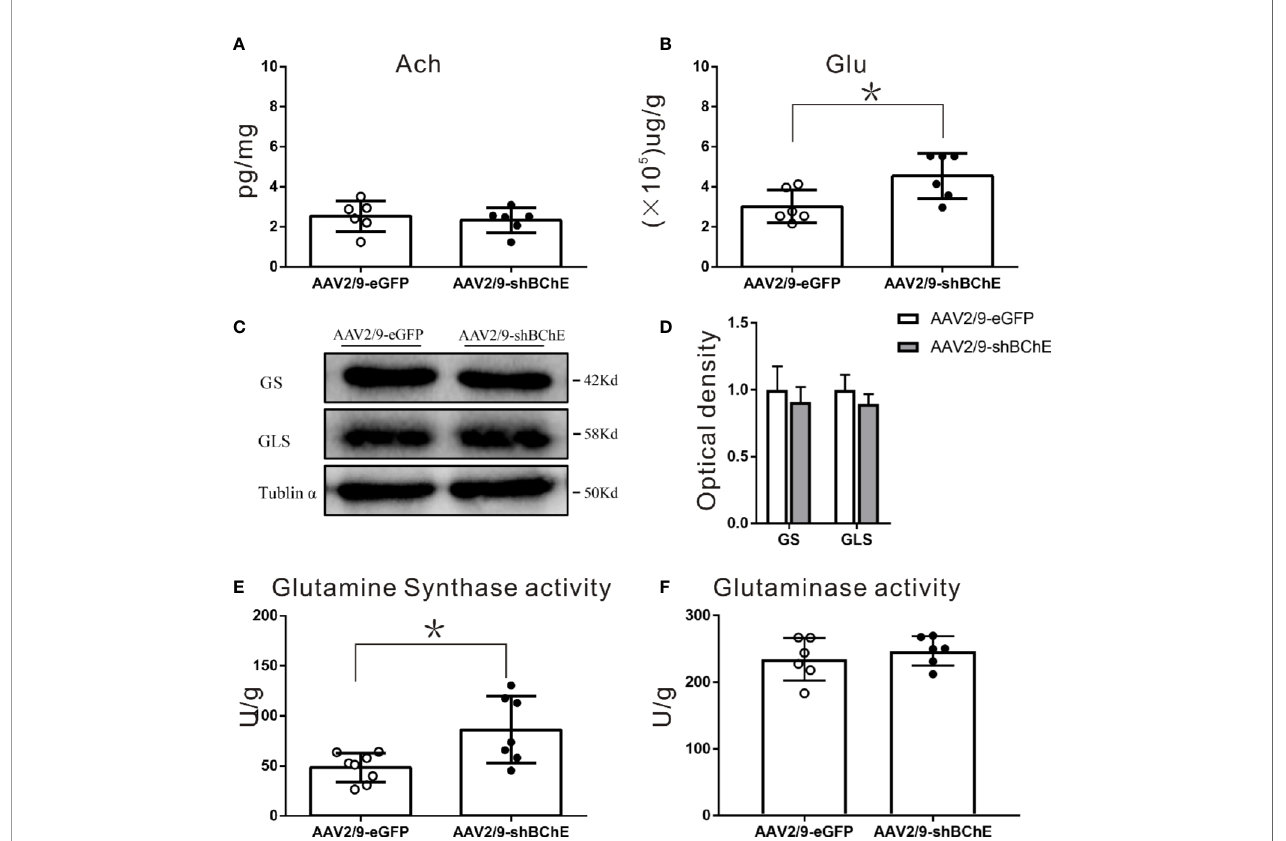
FIGURE 5 | BChE knockdown in the hippocampal CA1 region signi fi cantly increased Glu and GS enzyme activity in the hippocampal CA1 region after CFC. (A) Quanti fi cation of the concentration of ACh in the AAV2/9-shBChE and AAV2/9-eGFP groups. No signi fi cant differences were observed between the groups (p = 0.622; n = 6 mice per group). (B) The results showed a signi fi cant difference in Glu concentration between the two groups ( p = 0.015, * p < 0.05; n = 6 mice per group). (C, D) Western blots for GS and GLS. Three weeks following surgery, mice were sacri fi ced, and hippocampal CA1 tissues were analyzed by western blotting. There were no signi fi cant differences between the two groups. (E, F) Quanti fi cation of GS and GLS activities in the AAV2/9-shBChE and AAV2/9-eGFP groups. The results showed that only the enzyme activity of GS signi fi cantly was increased in the BChE knockdown group compared with the negative control group ( p = 0.024, * p < 0.05; n = 7 – 8 mice per group). The data are presented as the mean ±